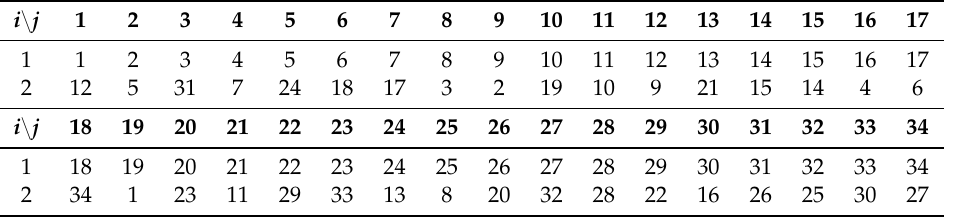
Table 4. Ranks r ij for observed insurance data from windstorm ( i in Example